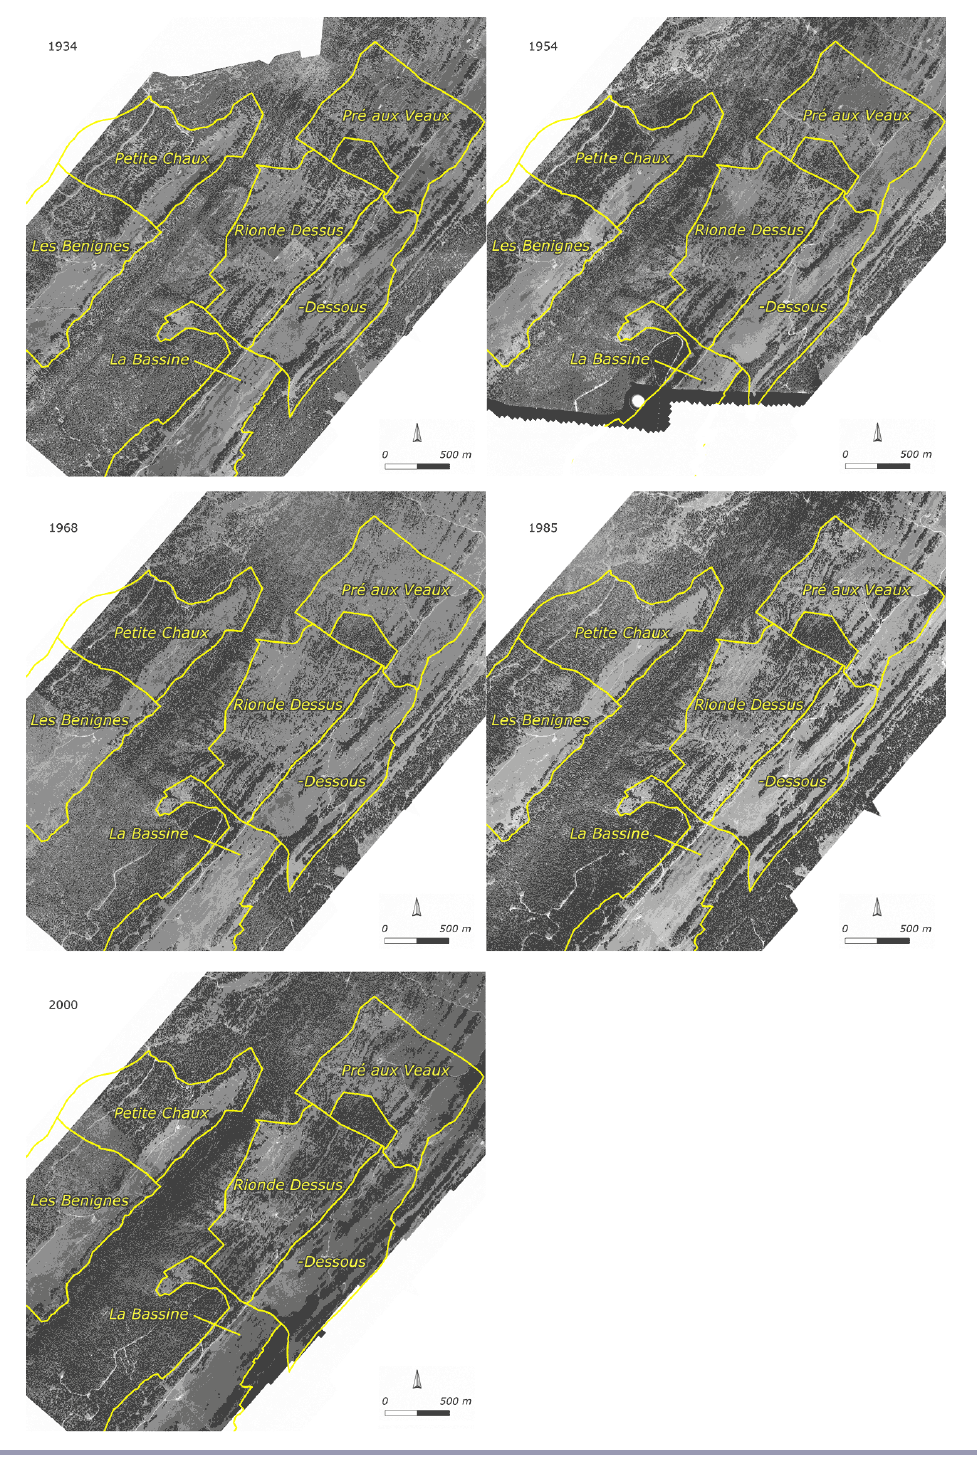
Fig. 4 . Aerial images of the pastures near Marchairuz showing their spatial organization, including the farms of Rionde Dessus and Rionde Dessous (source: